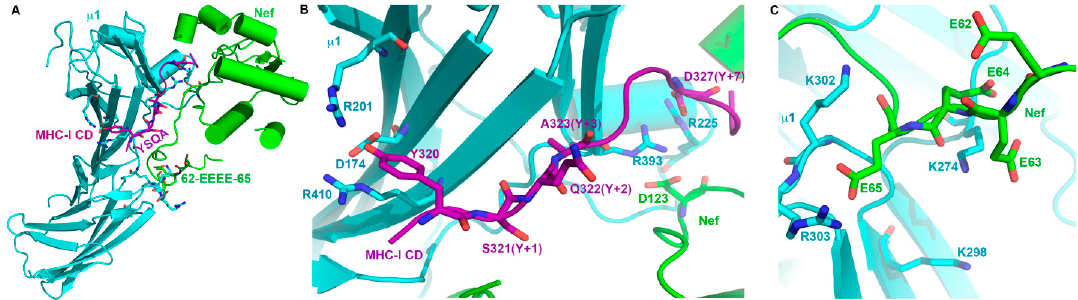
Figure 5. Structural interface between Nef, the MHC-I α chain cytoplasmic domain (CD), and the medium subunit of AP-1 ( µ 1). ( A ) Crystal structure of the ternary complex of Nef-MHC-I- α CD- µ 1 (PDB:4EN2). Nef is shown in green; MHC-I- α CD is shown in magenta; and µ 1 is shown in cyan. The membrane-proximal end of MHC-I- α CD containing the YSQA sequence and the acidic cluster of Nef are indicated. ( B ) Interaction of MHC-I- α CD YSQA sequence with the tyrosine-binding pocket residues (R201, D174, R410) of µ 1 is shown; and the ternary interaction of D327 of MHC-I- α CD with Nef D123 and µ 1 basic residues R225, R393 is also shown. ( C ) Interaction of Nef’s acidic